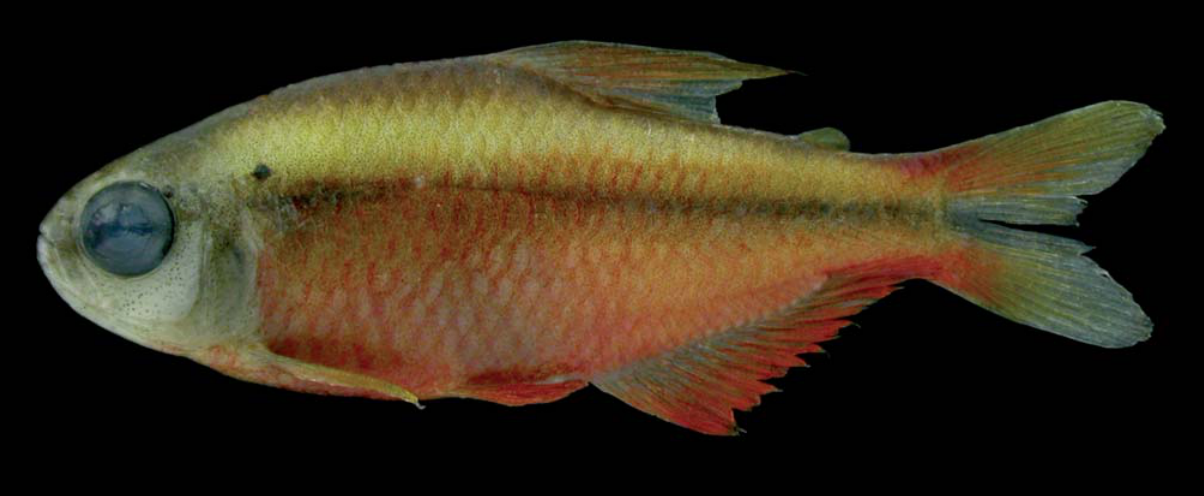
Fig. 6. Hyphessobrycon notidanos , MCP 38676, paratype, 25.7 mm SL, male, color just after